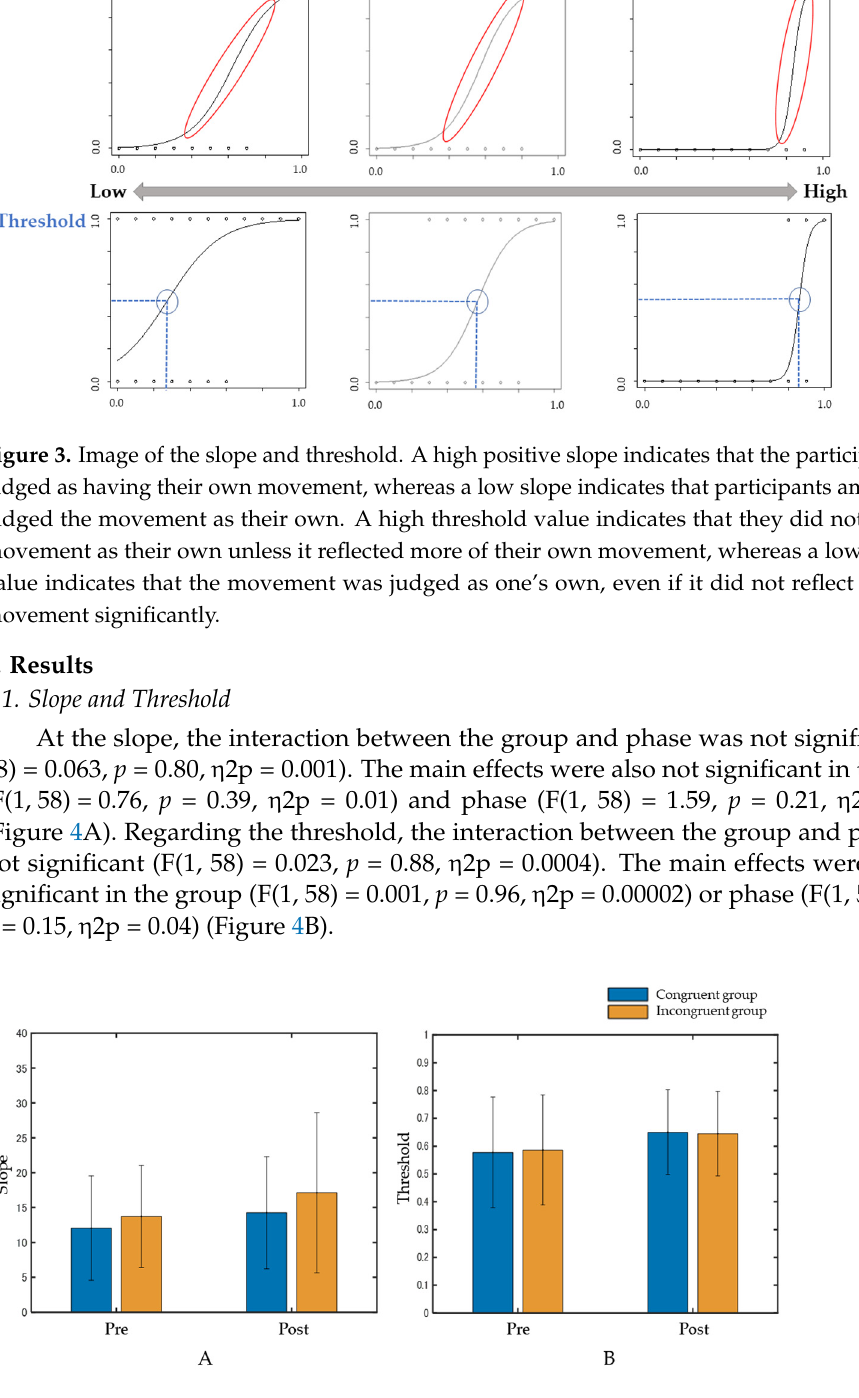
Table 1. Group comparison of psychological assessment.